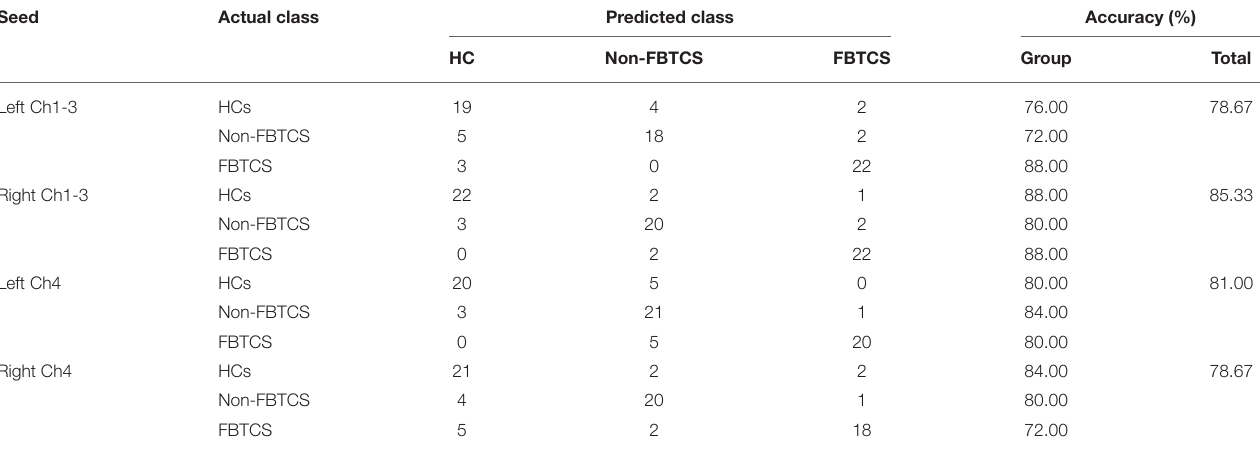
TABLE 3 | Results of multiclass classification.